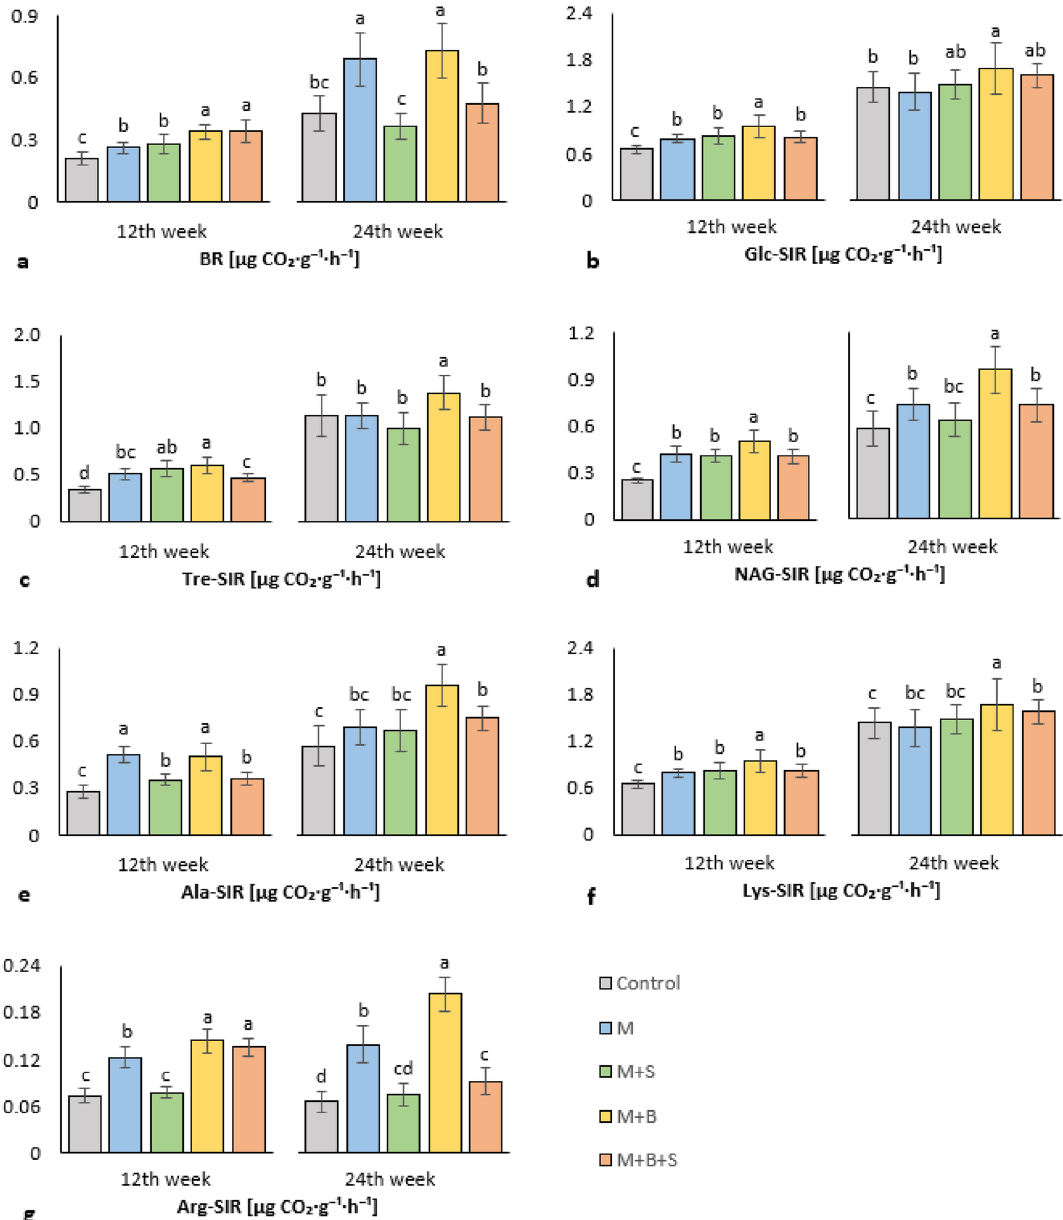
Figure 3. Soil basal ( a ) and D-glucose-induced ( b ) D-trehalose ( c ) and N-acetyl-b-D-glucosamine ( d ) induced respiration, L-alanine ( e ), L-lysine ( f ) and L-arginine ( g ) induced respiration after 12 and 24 weeks of cultivation . Average values (n = 4) are displayed, error bars are standard error of mean. The different letters of variant values indicate a statistical difference among them at the level p ≤